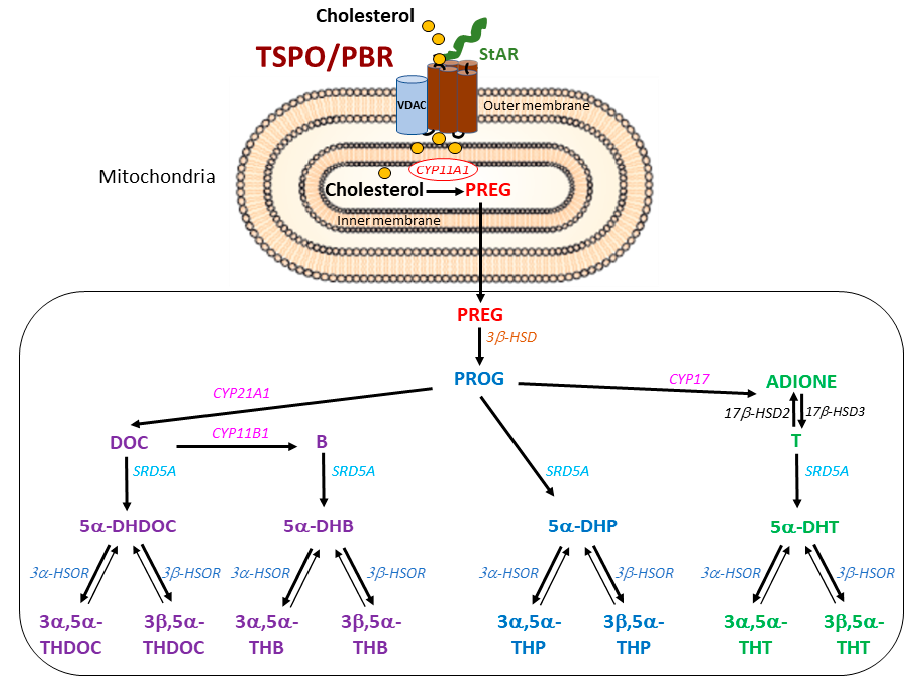
Figure 1. Cholesterol transport into the mitochondria and the enzymatic pathways of steroid synthesis from cholesterol in male mice. The current model involves the transport of cholesterol via StAR to the outer mitochondrial membrane of TSPO/PBR. Once cholesterol has entered mitochondria, it is converted by CYP11A1 into PREG, the precursor of all steroids. Progestogens (blue), mineralo- glucocorticoids (purple) and androgens (green) are the main families of steroids. PREG is further metabolized to PROG, the precursor of DOC and B. T is the major androgen formed from ADIONE, a direct product of PROG. PROG, DOC, B and T can then give rise to their respective 5 α - and 3 α /3 β -reduced metabolites. Irreversible enzymatic reactions are denoted by a single plain arrow and reversible ones are shown by a double-headed plain arrow. The abbreviated names of steroidogenic enzyme are in italics. CYP: cytochrome P450 family (CYP11A1: P450 side chain cleavage, CYP17: 17 β -hydroxylase,17–20 lyase, CYP21A1: 21 α -hydroxylase, CYP11B1: 11 β -hydroxylase), 3 β -HSD: 3 β -hydroxysteroid dehydrogenase- ∆ 5 → ∆ 4 isomerase, SRD5A: 5 α -reductase, HSOR: hydroxysteroid oxidoreductase, 17 β -HSD: 17 β -hydroxysteroid dehydrogenase. PREG: pregnenolone, PROG: progesterone, DOC: 11-deoxycorticosterone, B: corticosterone, DHP: dihydroprogesterone, THP: tetrahydroprogesterone, DHDOC: dihydrodeoxycorticosterone, THDOC: tetrahydrodeoxycorticosterone, DHB: dihydrocorticosterone, THB: tetrahydrocorticosterone, T: testosterone, DHT: dihydrotestosterone, THT: tetrahydrotestosterone, ADIONE: androstenedione. VDAC: voltage-dependent anion channel.